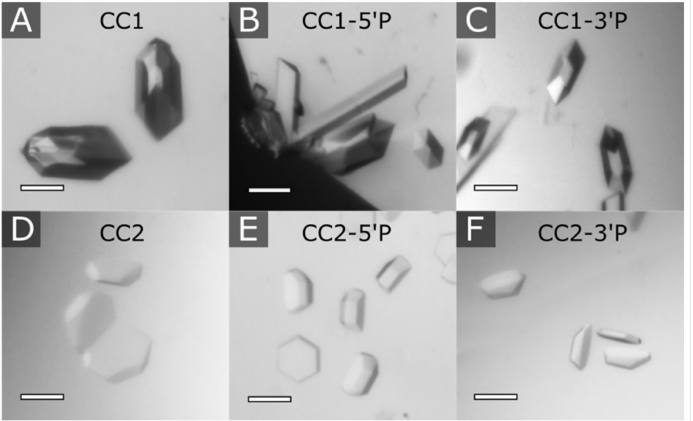
Figure 3. Examples of six co-crystal variants relative to a 100 micron scale bar. The CC1 crystals have C121 symmetry and tend to grow as monoclinic prisms: ( A ) CC1 without terminal phosphates, ( B ) CC1 with terminal 5 (cid:48) phosphate, and ( C ) CC1 with terminal 3 (cid:48) phosphate. In contrast, CC2 crystals have P3221 symmetry and tend to grow as truncated hexagonal prisms: ( D ) CC2 without terminal phosphates, ( E ) CC2 with terminal 5 (cid:48) phosphate, and ( F ) CC2 with terminal 3 (cid:48)